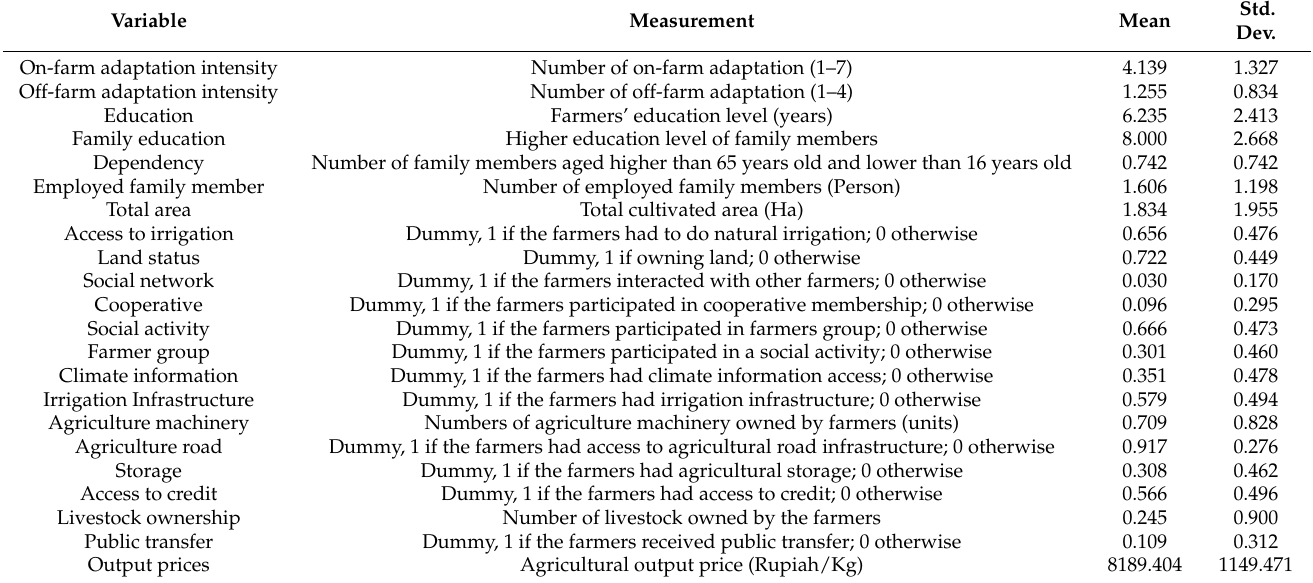
Figure 3. Off-farm adaptation practices. Table 1. Descriptive statistics and measurement of study